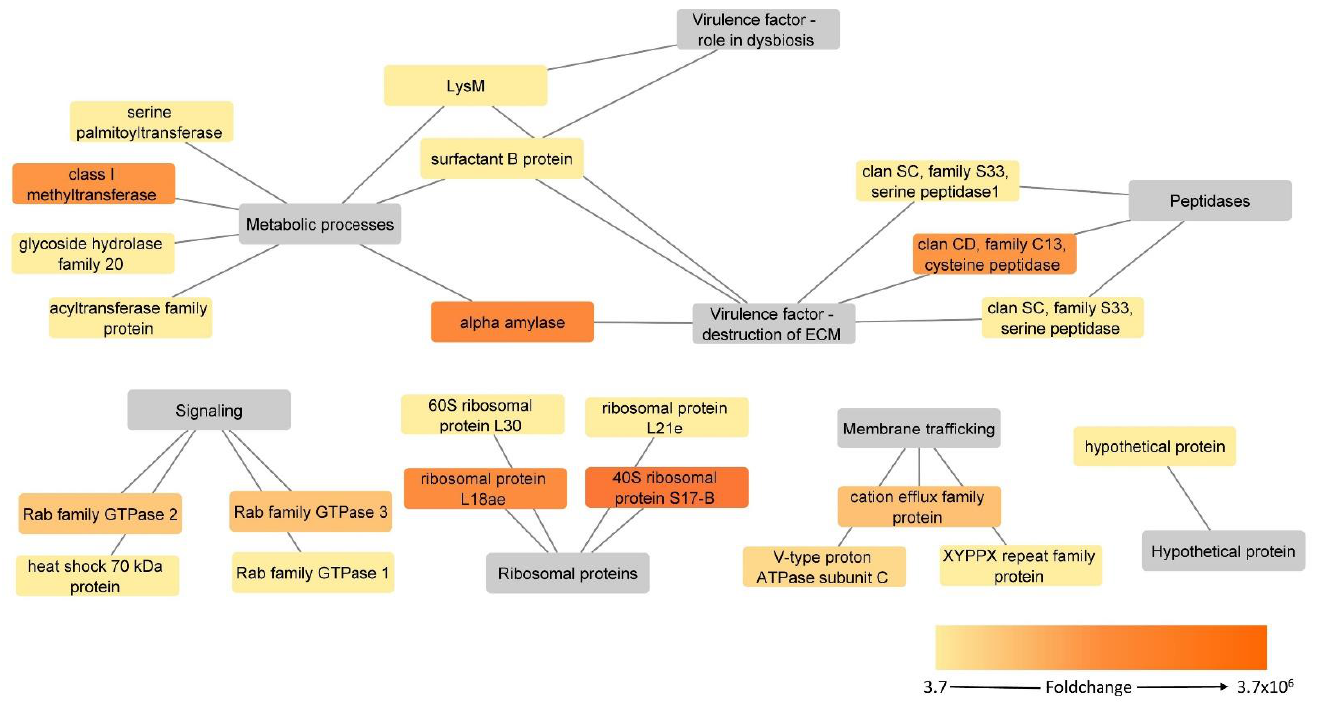
Figure 6. Putative surface-associated, upregulated proteins in the virulent strain of H. meleagridis . Protein-function network graphs of H. meleagridis proteins with significant upregulation in the virulent strain (>2 fold change and p < 0.05). The protein identifications are represented by color-coded source nodes and connected with their proposed functions, represented by the target nodes. The source nodes are color-coded based on each protein fold change upregulation.